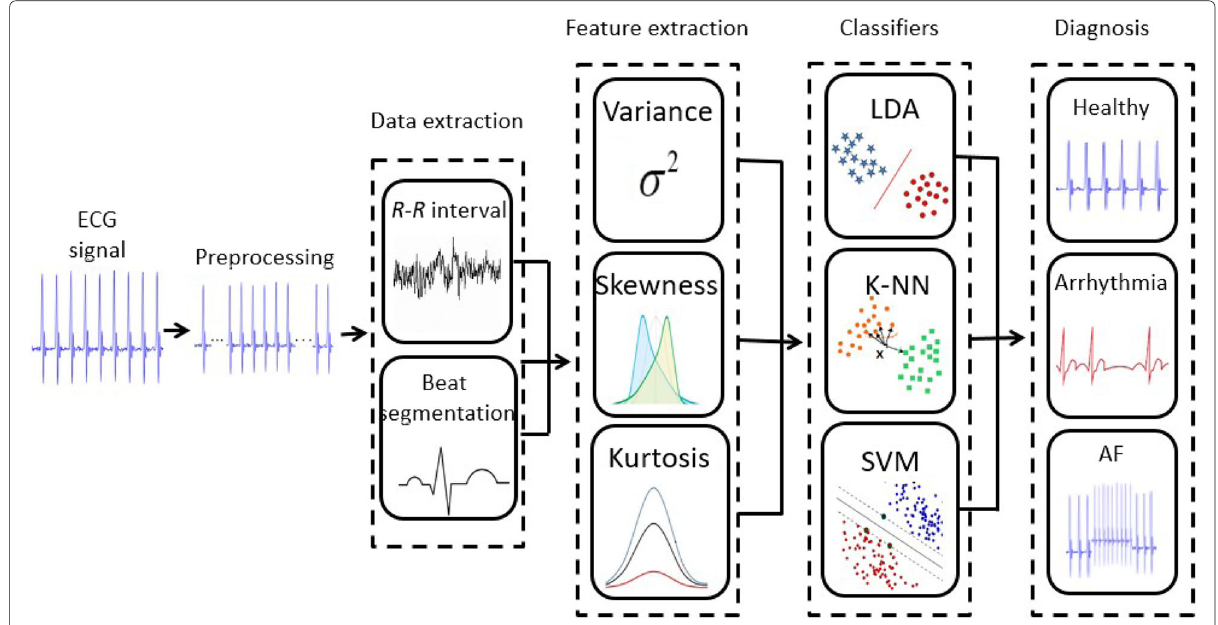
Fig. 1 Block diagram of the segmentation and classification of ECG